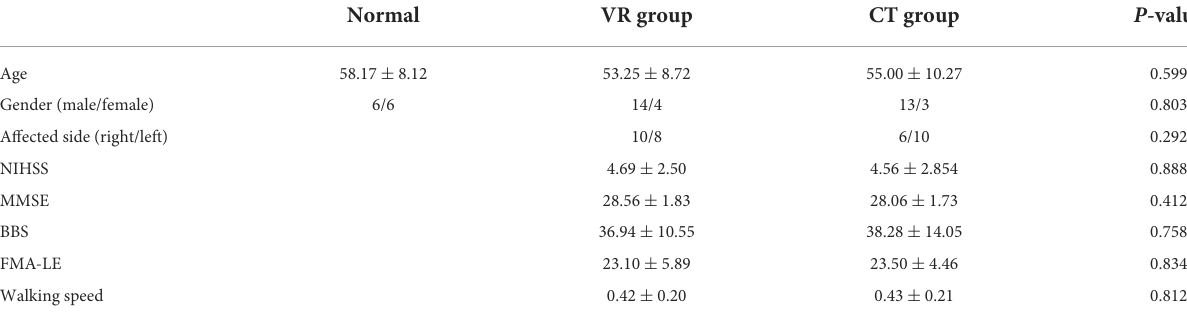
TABLE 2 Demographic characteristics (Mean ± SD) at baseline for three groups.